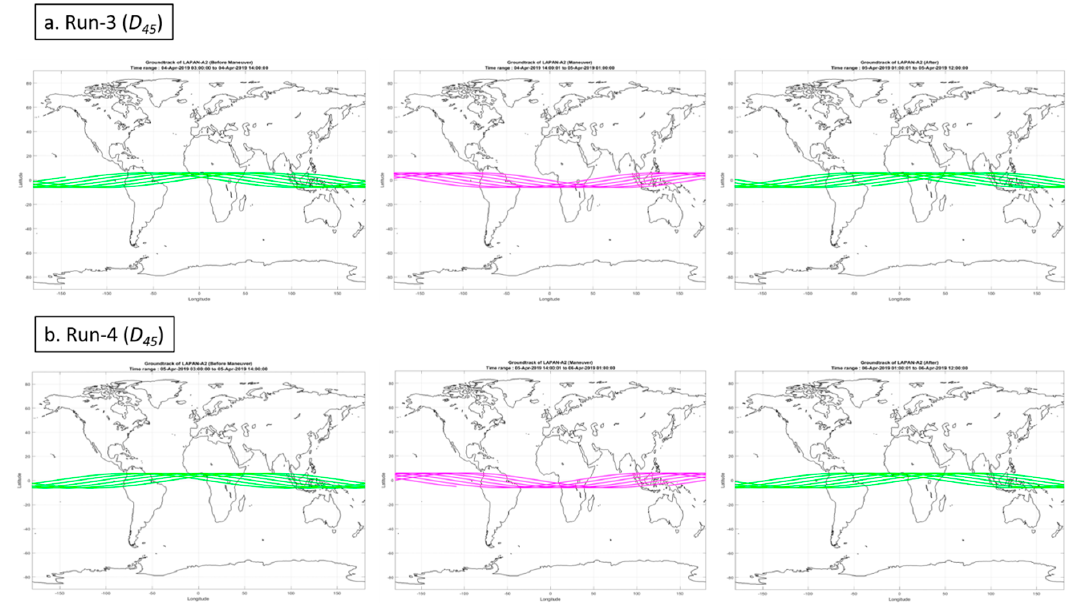
Figure 12. The LAPAN-A2 satellite ground track produced during the 45 ◦ -maneuvered observation